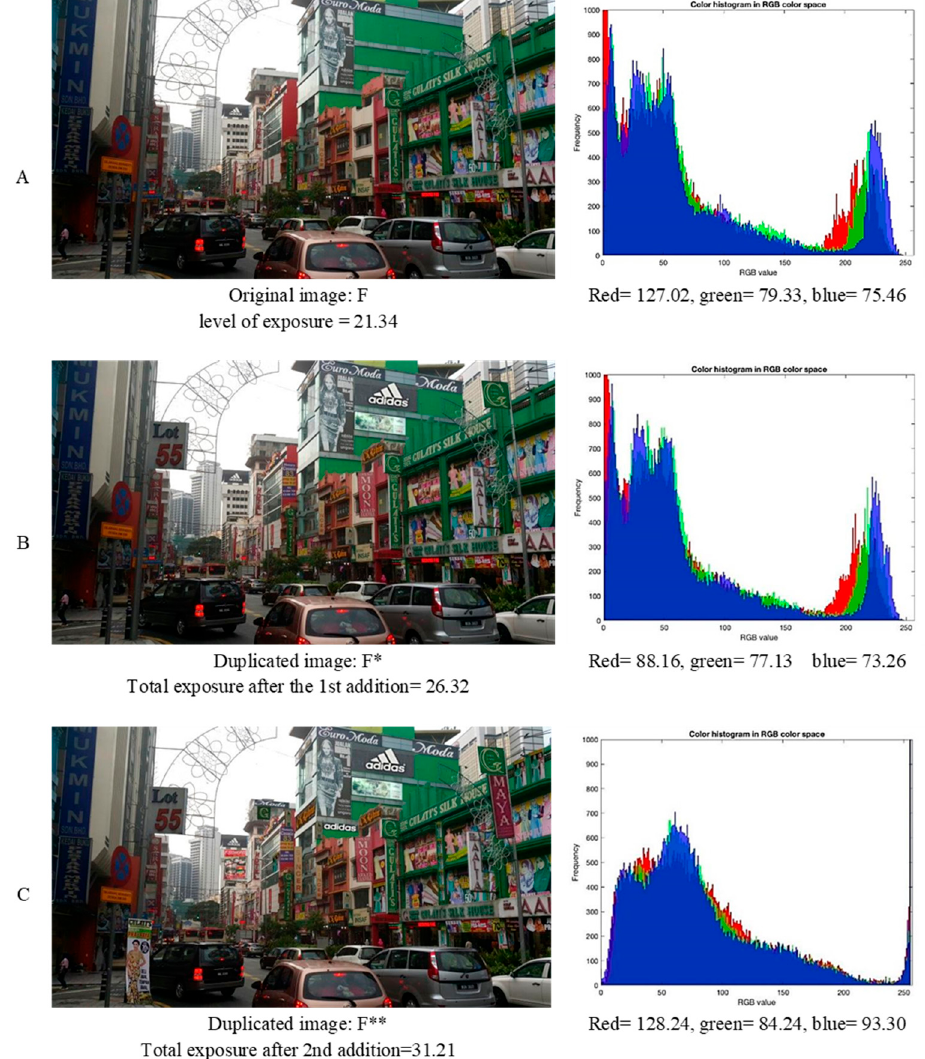
Figure 9. A sample original picture (Code F), the additions made of approximately 5% increments, and the respective RGB histogram. Whereby ( A ) represents the original photo, ( B ) represents the photo after 1st addition, and ( C ) represents the photo after 2nd addition.